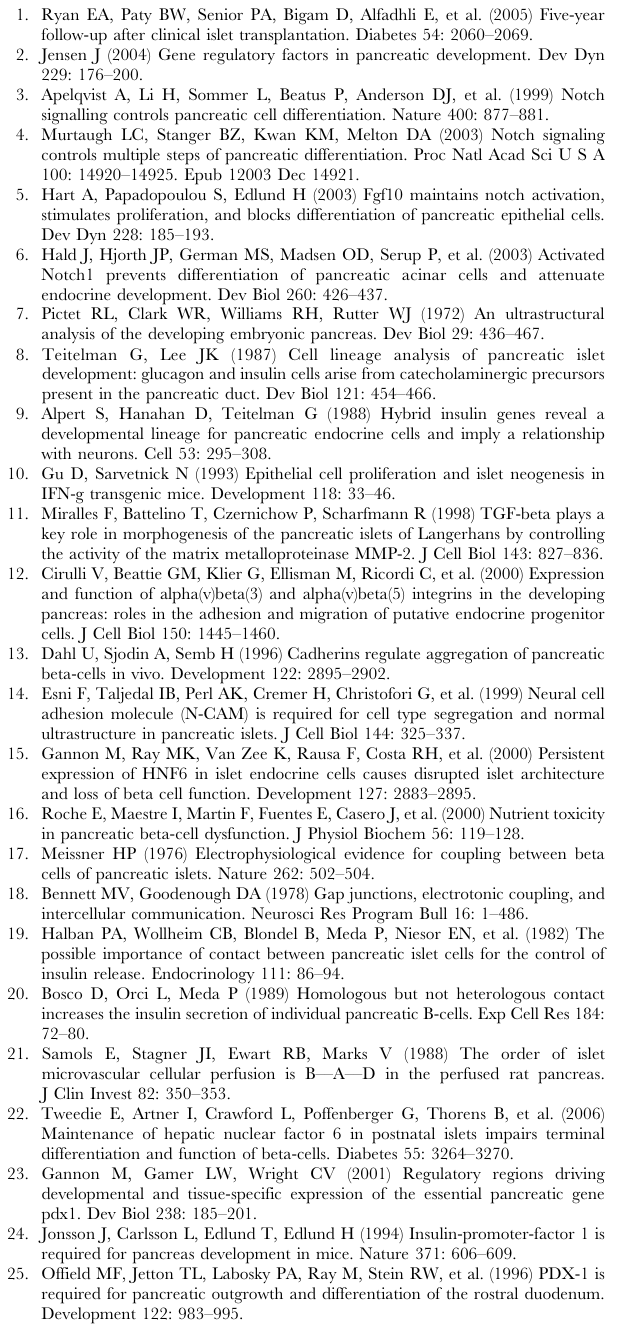
Table S3 Intersection of transcripts altered at both e18.5 and P1 in Hnf6 Tg pancreata. Down- (A) and up-regulated (B) genes common to both e18.5 and P1 data sets as determined by a change in gene expression of 1.5-fold or